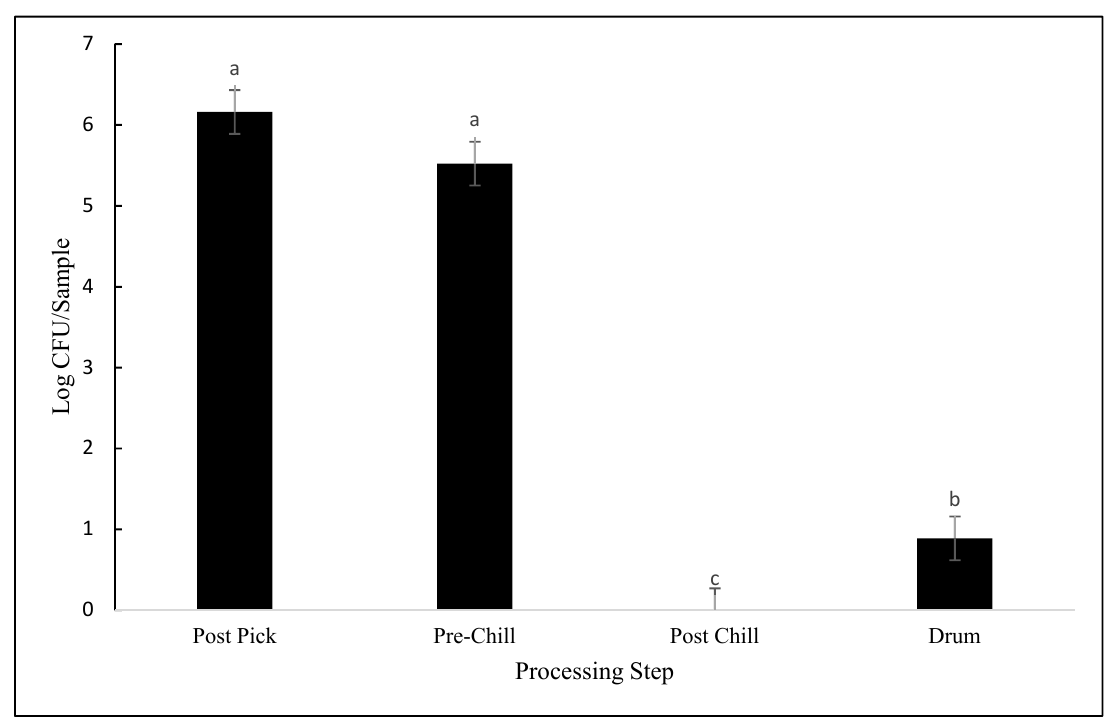
Figure 3. Coliform contamination expressed as log CFU/sample, detected from samples collected at post ‐ pick, pre ‐ chill, post ‐ chill, and drumsticks ( p < 0.001). Means with different letters differ statistically.